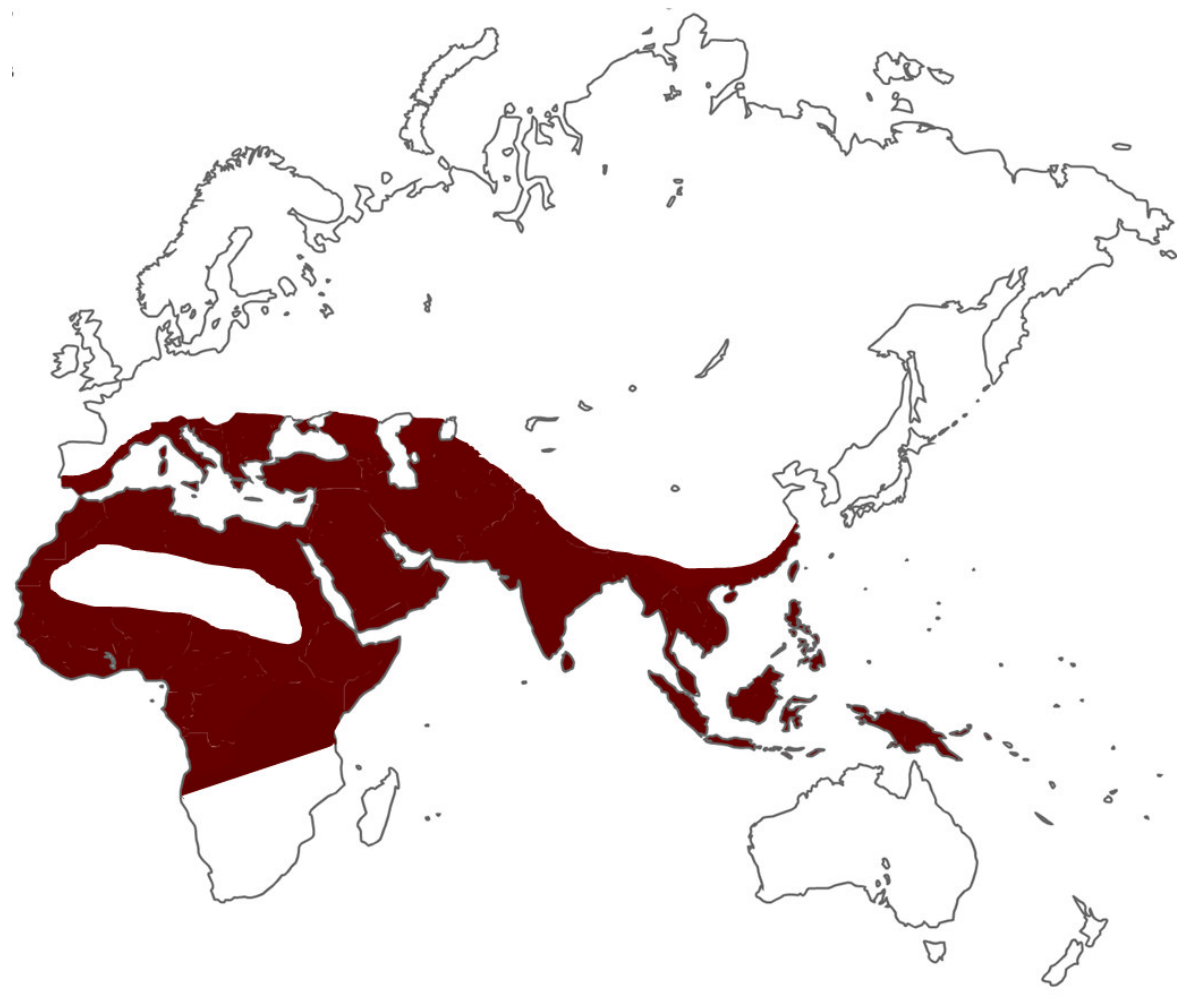
FIGURE 1. World distribution of α -thalassemia. Affected locations are represented by dark red areas ( ■